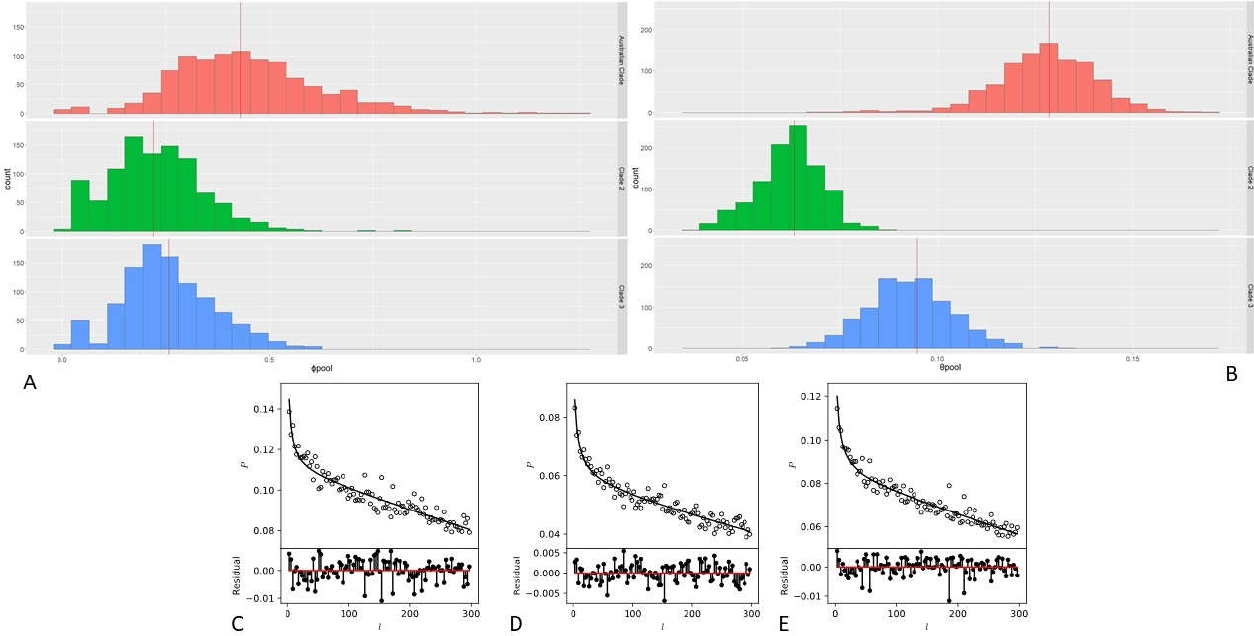
Figure 5. Recombination and mutation mcorr profiles. ( A , B ) Histograms of ϕ pool and θ pool values from 1000 bootstrap replicates of Australian clade (red), Clade 2 (green) and Clade 3 (blue) isolates. Mean values are represented by vertical red lines. ( C – E ) Correlation profiles analysis of (left to right) Australian Isolates, Clade 2 isolates and Clade 3 isolates of E. rhusiopathiae . Model fits are shown as solid lines and correlation profiles of all pairs are shown as open circles.